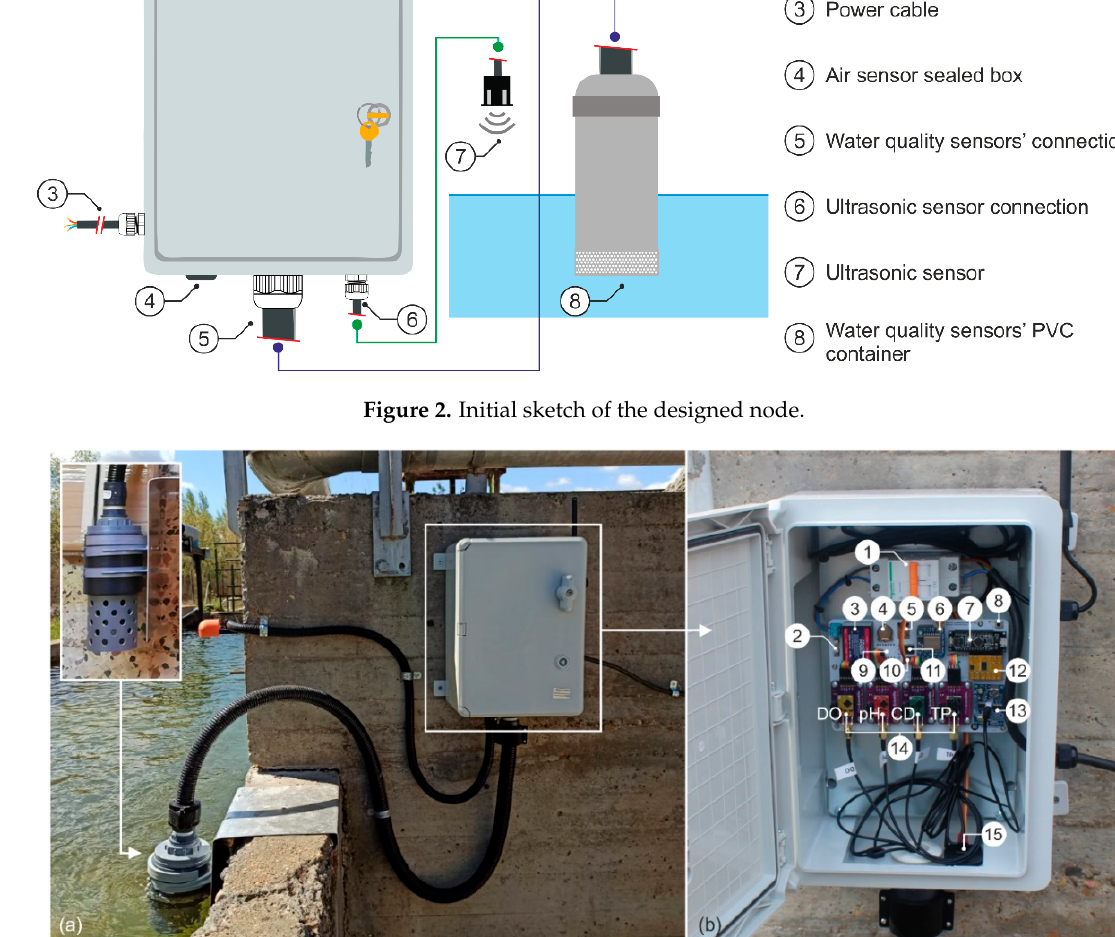
Figure 2. Initial sketch of the designed node.